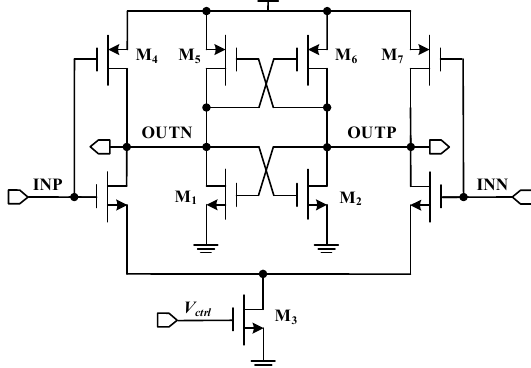
Figure 8. The proposed SET-hardened VCO.